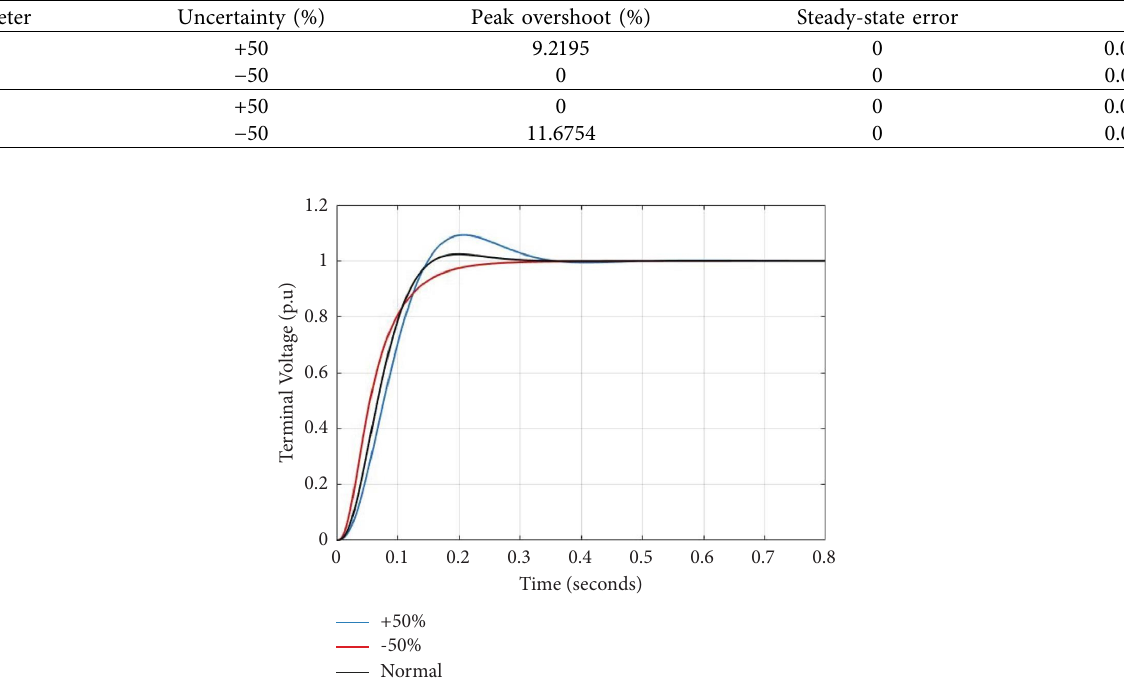
Figure 14: Response of terminal voltage using MESOBC for normal and ± 50% uncertainties in T